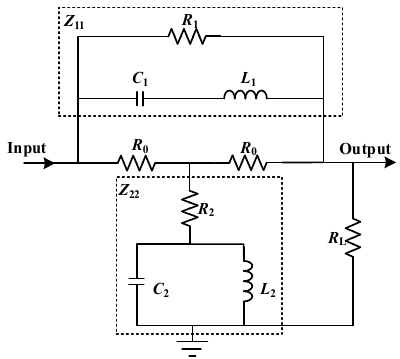
Figure 4. Schematic of the bridged-T pre-equalization circuit.